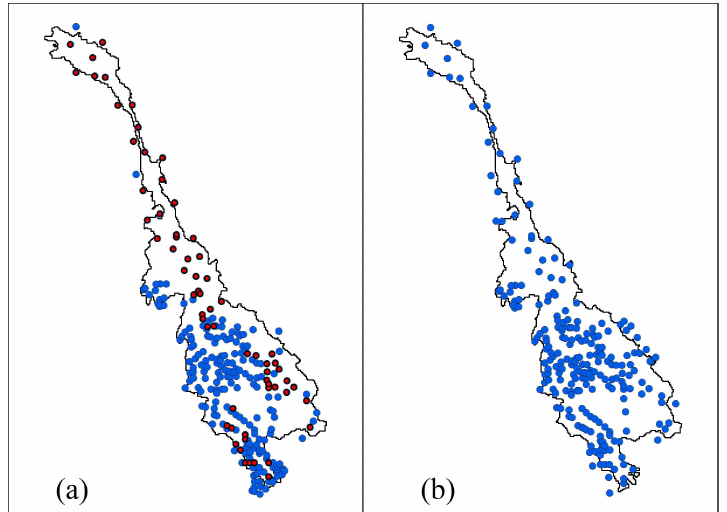
Figure 4. ( a ) The spatial distribution of precipitation stations with observation data from 1998 to 2007, and the red point means that there were no missing observation data at this station. ( b ) The spatial distribution of precipitation stations with observation data from 1979 to 1997 and 2008 to